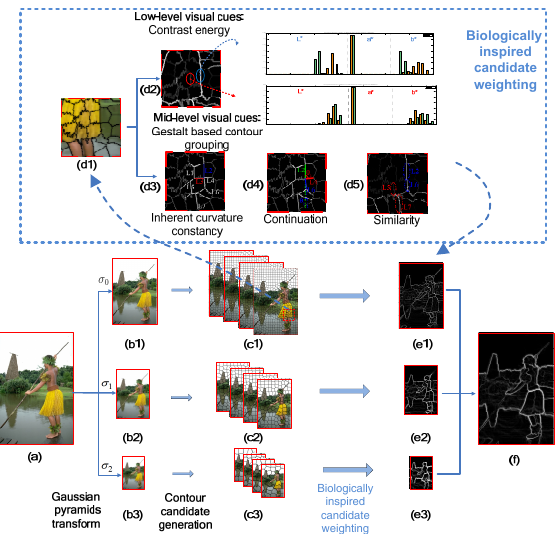
Figure 1. Flowchart of our contour detection framework. ( a ) Input image; ( b1 – b3 ) transformed images of different scales ( σ generated by our modified simple linear iterative clustering (SLIC) processing. We perform SLIC with four different initials in each